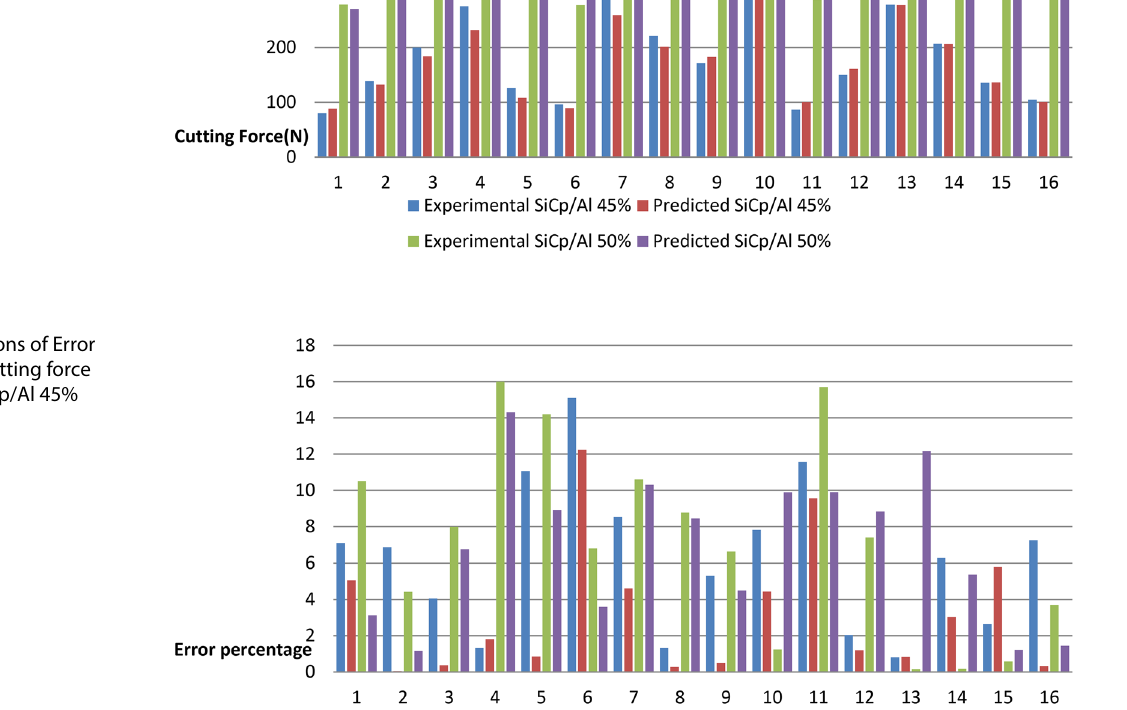
Fig. 25 Comparisons of Experi- ment values and Predicted values of Cutting force of F z of SiCp/Al 45% and 50%